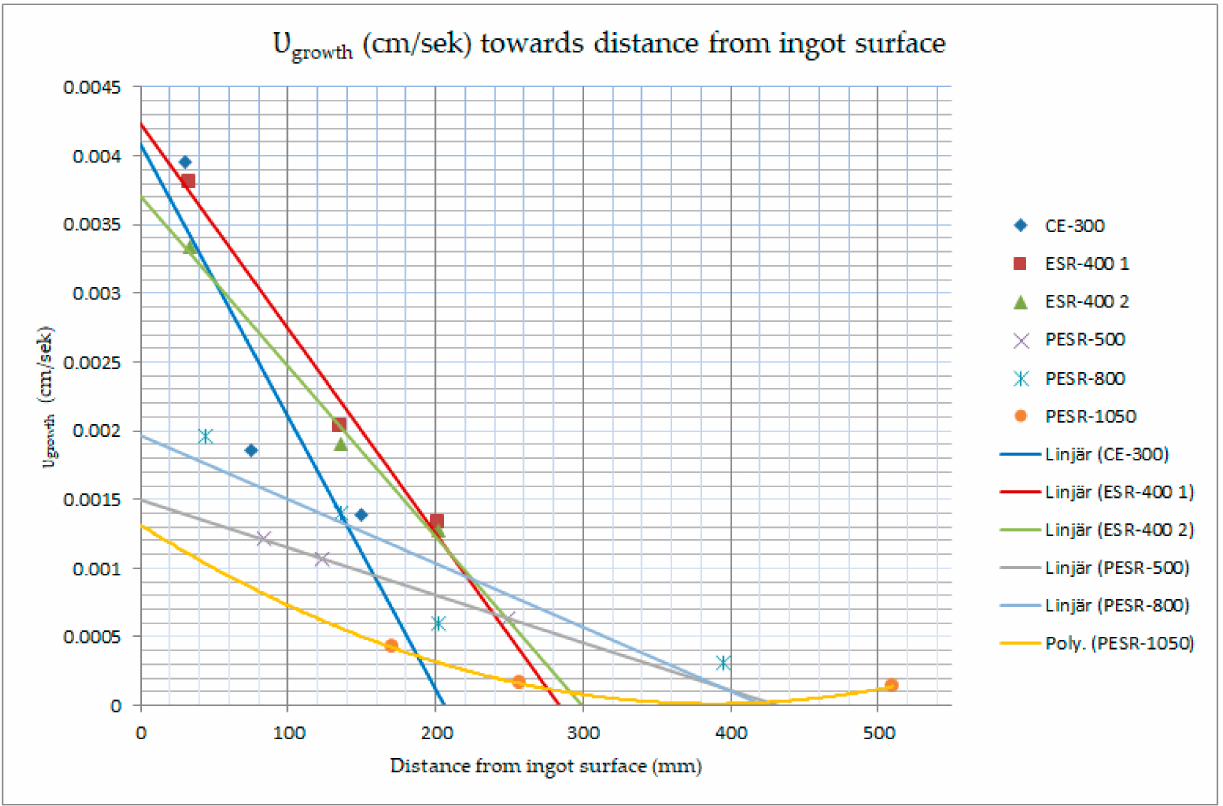
Figure 12. Growth rate towards distance from ingot surface. Equation (1) is just valid for columnar dendritic growth, the nonlinear connection for the pressure electro-slag remelted 1050 mm in diameter ingot (PESR-1050) indicates that it solidifies equiaxial in the